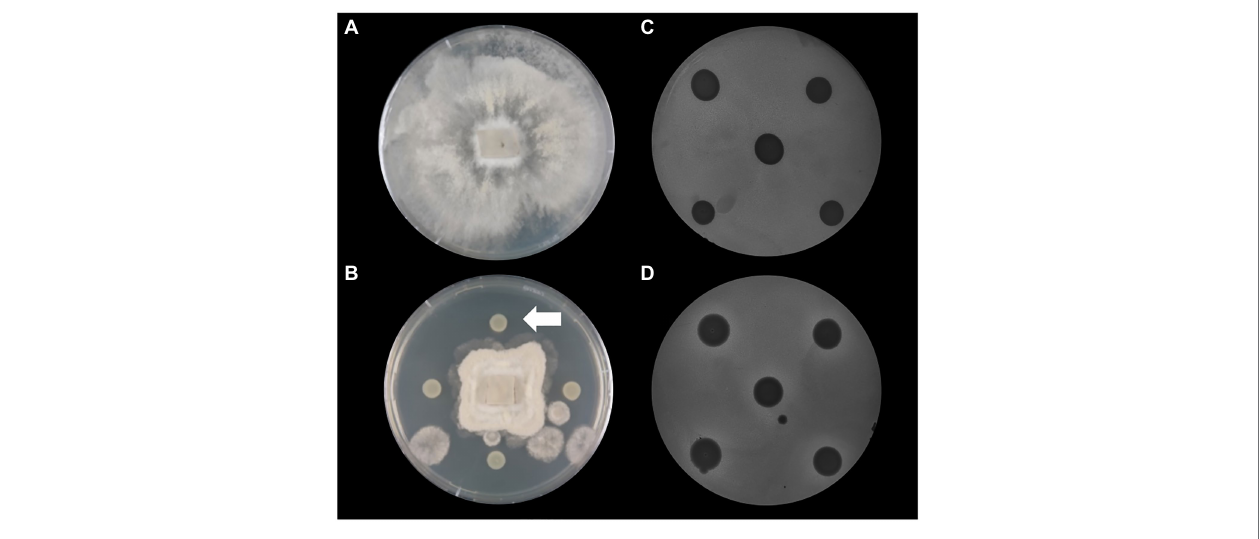
FIGURE 3 | Antagonistic activities against phytopathogens. (A) Botrytis cinerea control; (B) B. cinerea + P. thivervalensis SC5; (C) Pseudomonas syringae DC3000 (incorporated in agar) + Pseudomonas sp. MS8 (negative control); (D) P. syringae DC3000 (incorporated in agar) + P. thivervalensis SC5. The arrow in panel (B) points to a P. thivervalensis SC5 colony. The inhibition of fungal growth and the presence of halos ( P. syringae DC3000 assay) indicate the antagonistic activities of strain